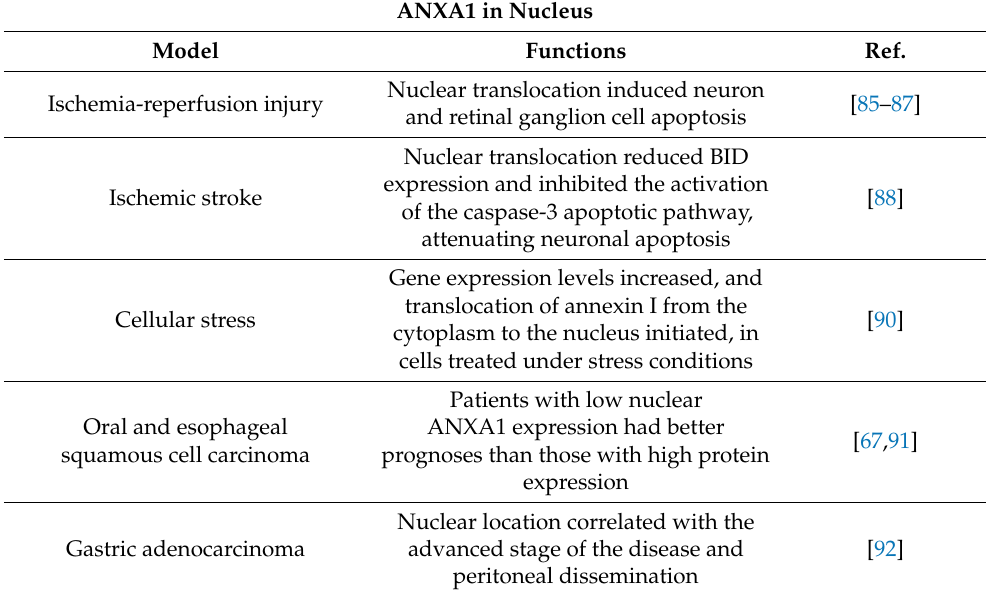
Table 1. ANXA1 in the